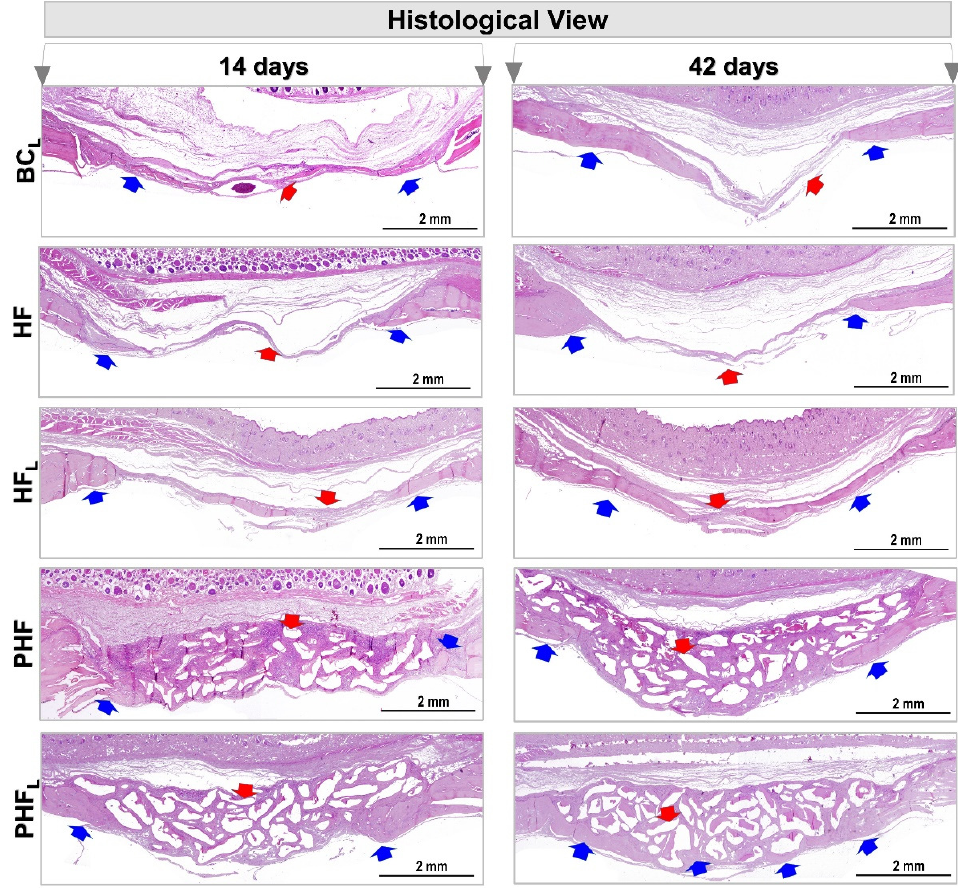
Figure 3. Panoramic histological view of cranial defects created in animals at 14 and 42 days. ( n = 12/group): BC L , HF, HF L , PHF and PHF L groups. Panoramic aspects of the calvaria showing height and conformation compromising the type of treatment. At 14 days, in BC L , HF and HF L , areas of defects filled predominantly by connective tissue (red arrow), were observed mainly in BC L , with areas of neoformed bone tissue (blue arrow) on the edges of the defect, and by rich connective tissue in cells and vascularized in the most central region. In the PHF and PHF L groups, centripetal bone growth at the margins of the surgical area, presence of connective tissue permeating the biomaterial particles (red arrow). At 42 days, bone growth remained restricted to the margins of the defect, and wound closure was predominantly by connective scar tissue and/or biomaterial. (HE original magnification 4×; bar = 2 mm).